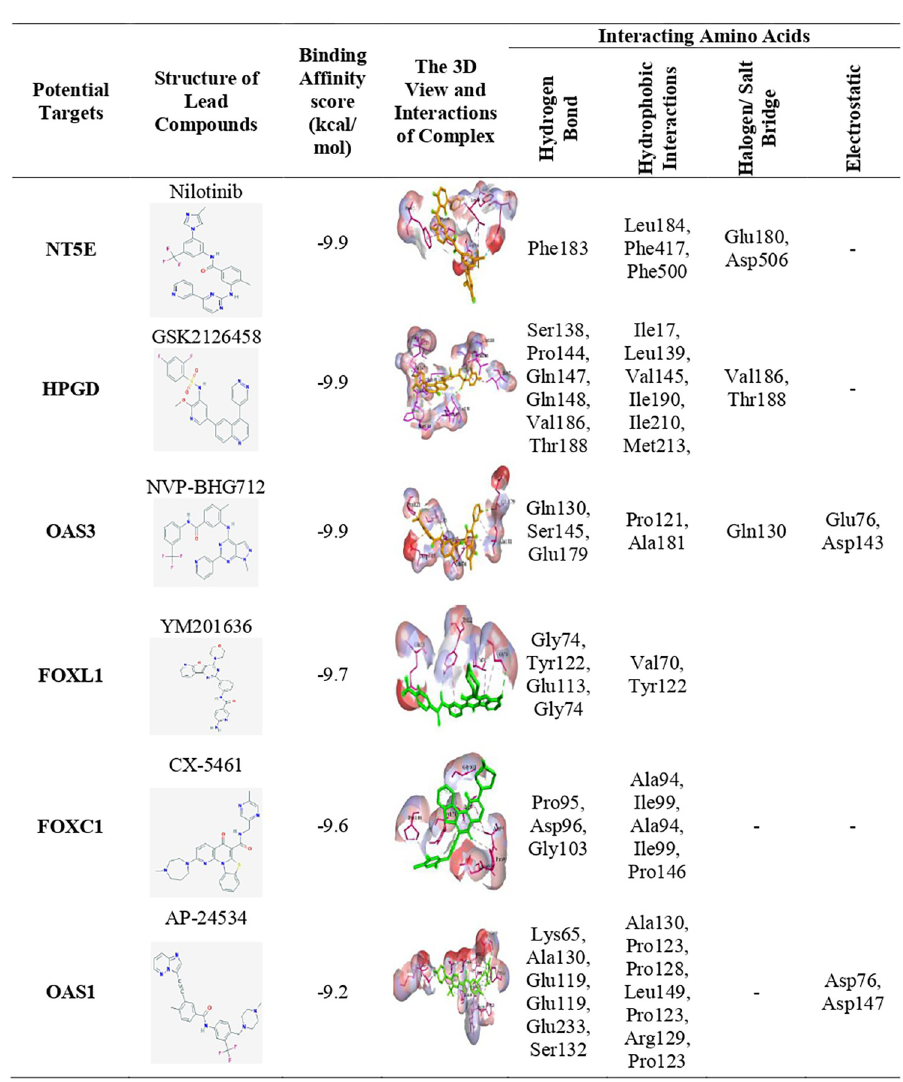
Fig 7. The 3D views of the selected strong binding interactions between drug targets and agents were displayed. The key interacting amino acids and their binding types with potential targets were also